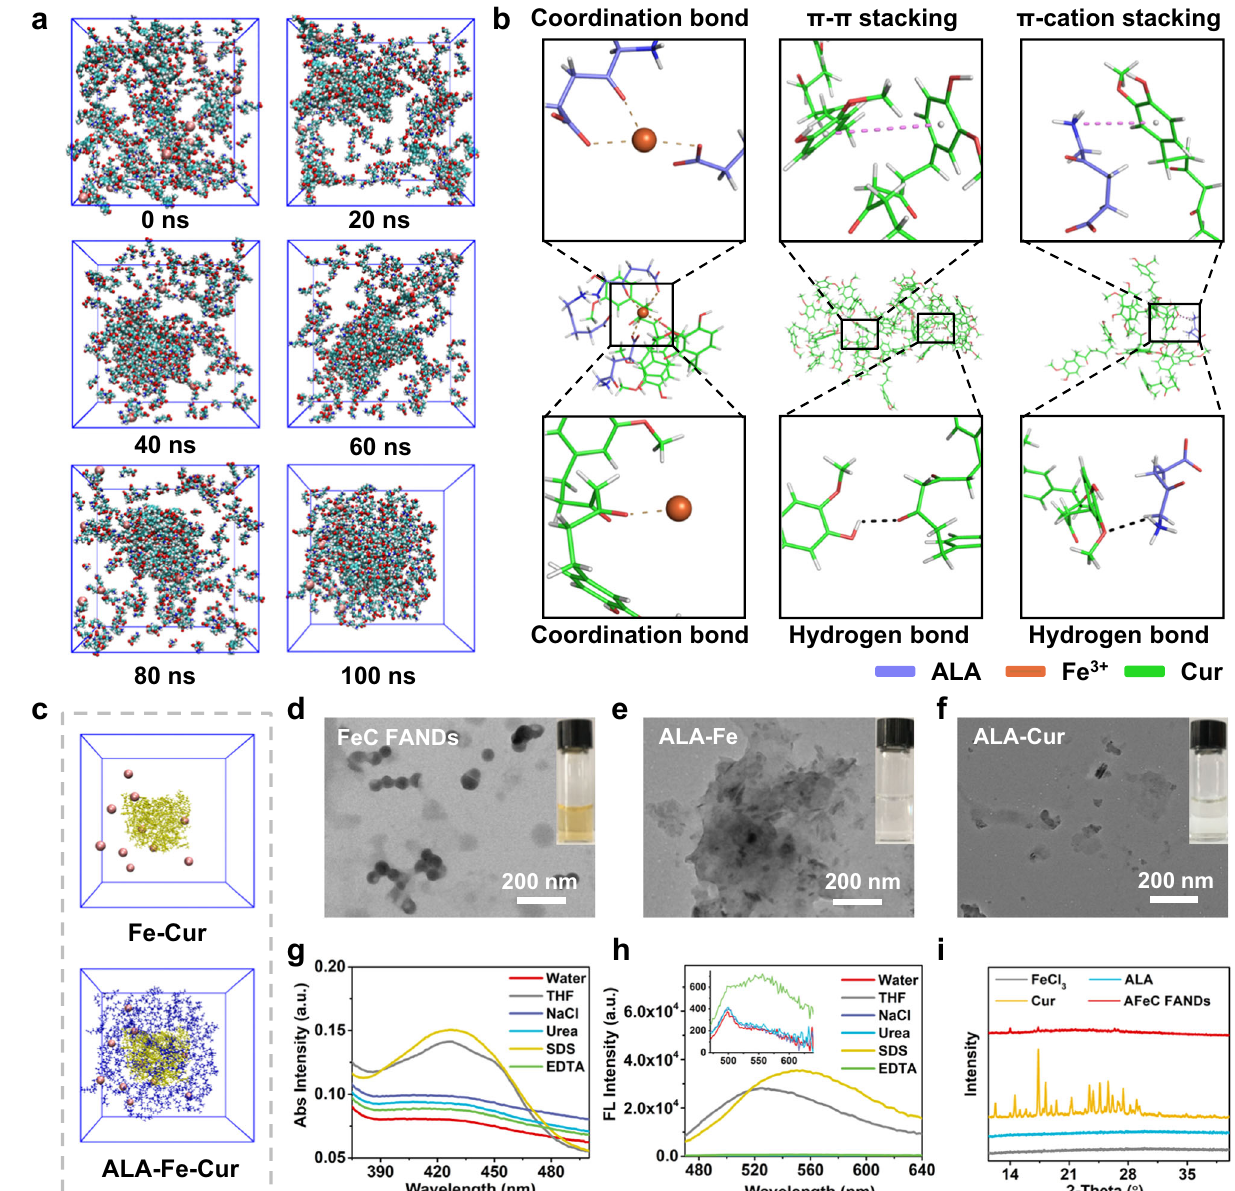
Fig. 3 | Formation mechanisms of the AFeC FANDs. a Molecular cluster changes of 5-aminolevulinicacid (ALA),FeCl 3 , and curcumin(Cur)during 100nssimulation (blue balls: carbon; deep blue balls: nitrogen; red balls: oxygen; white balls: hydrogen; brown balls: Fe 3+ ). b Intermolecular interactions analysis in the AFeC FANDs. c Evolution of aggregates without or with ALA simulated by molecular dynamics (brown: Fe 3+ ; yellow: Cur; blue: ALA). d – f TEM images of the FeC FANDs,